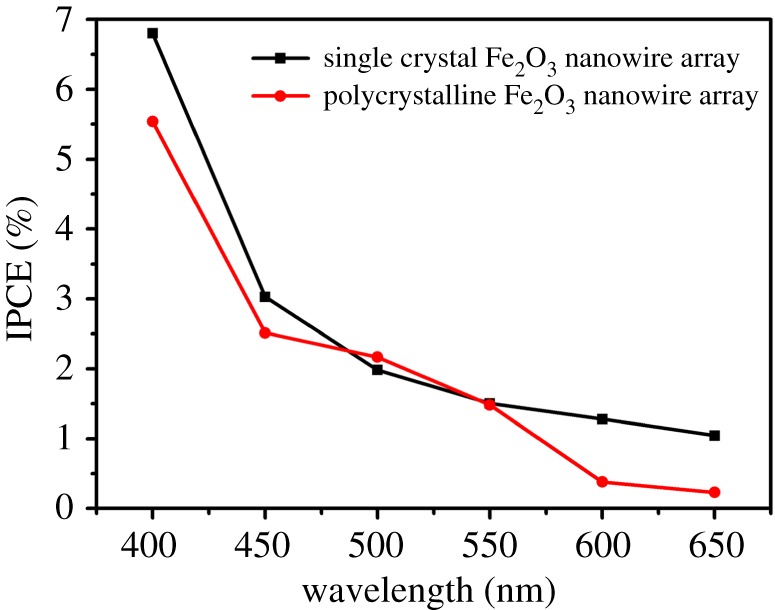
IPCE of the Fe2O3 nanowire array photoanode at 0.234 V versus Ag/AgCl (1.23 V versus RHE).